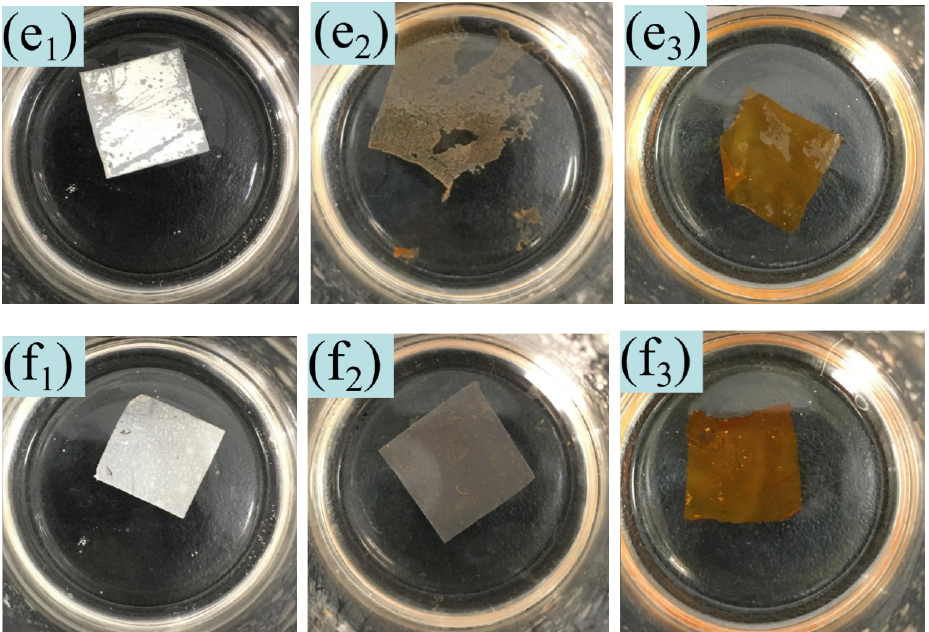
Figure 5. Morphologies of nanoscale urushiol/PAN films immersed in ( a 1 ) 60%, ( a 2 ) 80%, and ( a 3 ) 100% sulfuric acid solutions for 30 min: ( a ) Without urushiol (5% PAN), ( b ) 3:5, ( c ) 4:5, ( d ) 5:5, ( e ) 6:5, ( f ) 7:5.